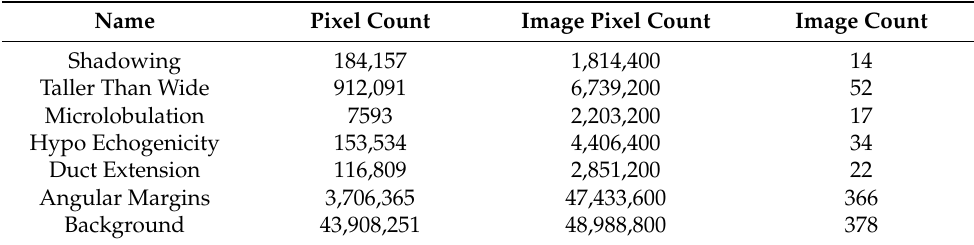
Table 2. Selected lexicons in this study and the image/pixel count of the